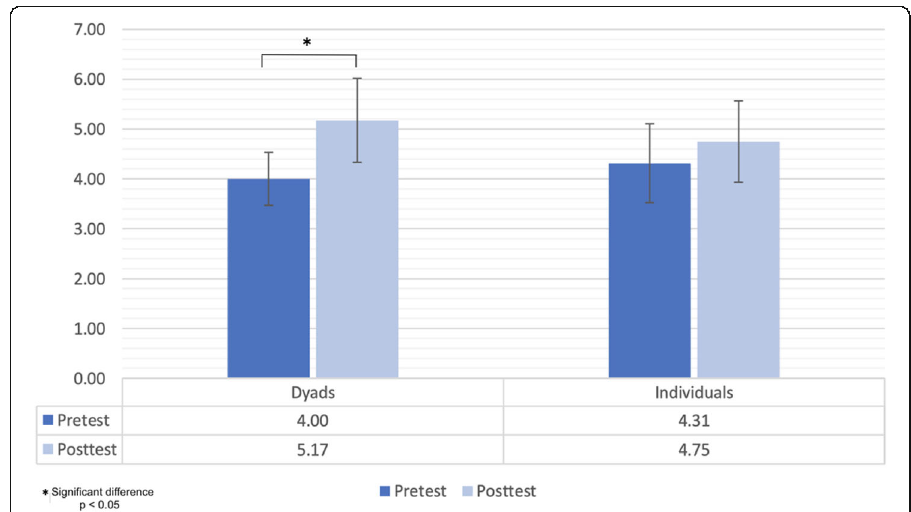
Fig. 5 Bar chart representing the mean pretest and posttest scores of participants who performed the AR learning activities in dyads and